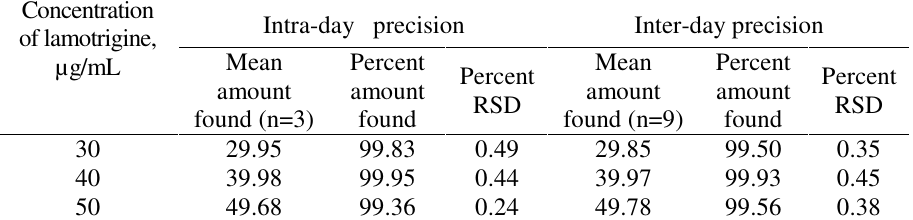
Table 2. Precision of the proposed method